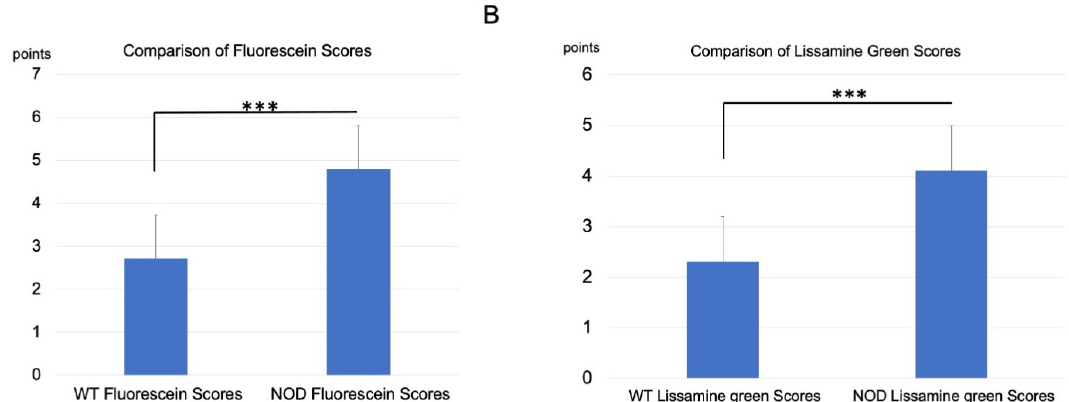
Figure 2. Comparison of vital staining scores between the wild-type (WT) and NOD mice. ( A ) Flu- orescein staining scores in the NOD mice were significantly higher than those in the WT mice ( p < 0.0001). ( B ) Lissamine green staining scores in the NOD mice were also significantly higher than those in the WT mice ( p < 0.0001). *** represents p < 0.0001.